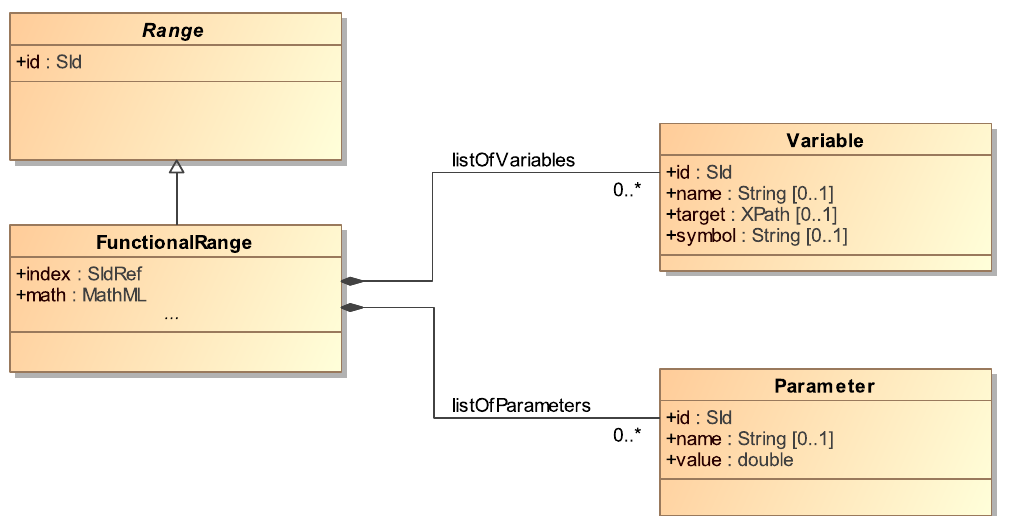
Figure 2.37: The SED-ML FunctionalRange